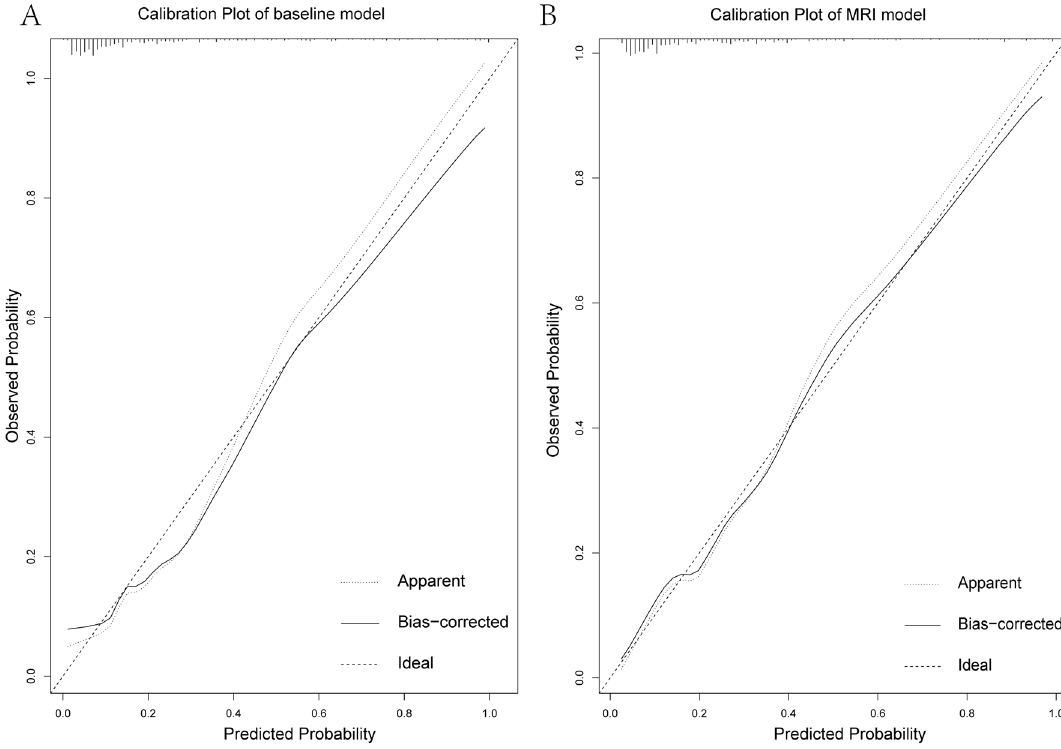
Figure 1. Calibration plot showing mean predicted risk in the validation cohort. ( A ) Calibration plot of the baseline model, ( B ) Calibration plot of the MRI